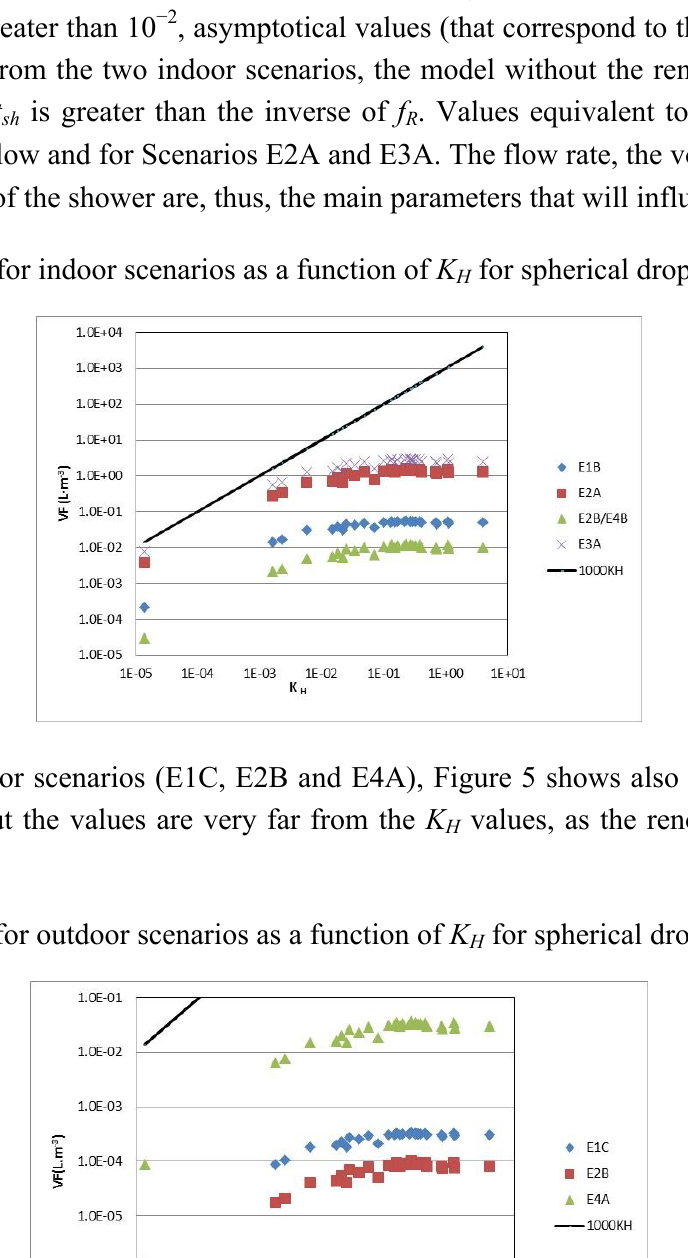
Figure 4. VFs for indoor scenarios as a function of K